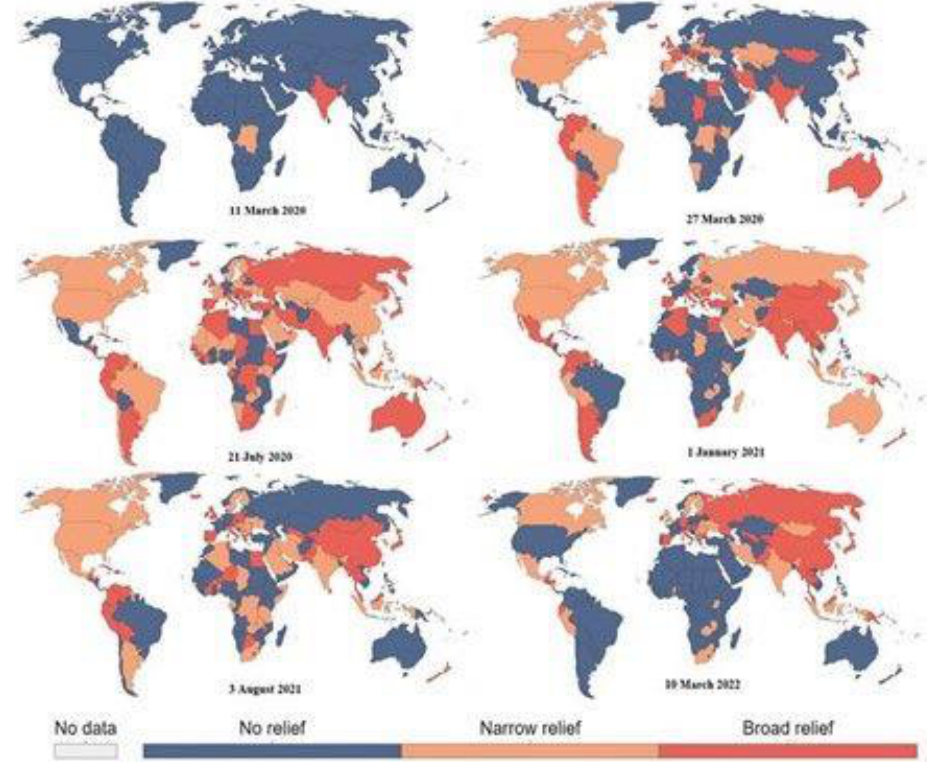
Figure 2. Income support during the COVID-19 pandemic. Source: Authors ’ calculations based on the OxCGRT. https://ourworldindata.org/covid-income-support-debt-relief (accessed on 15 April 2022).